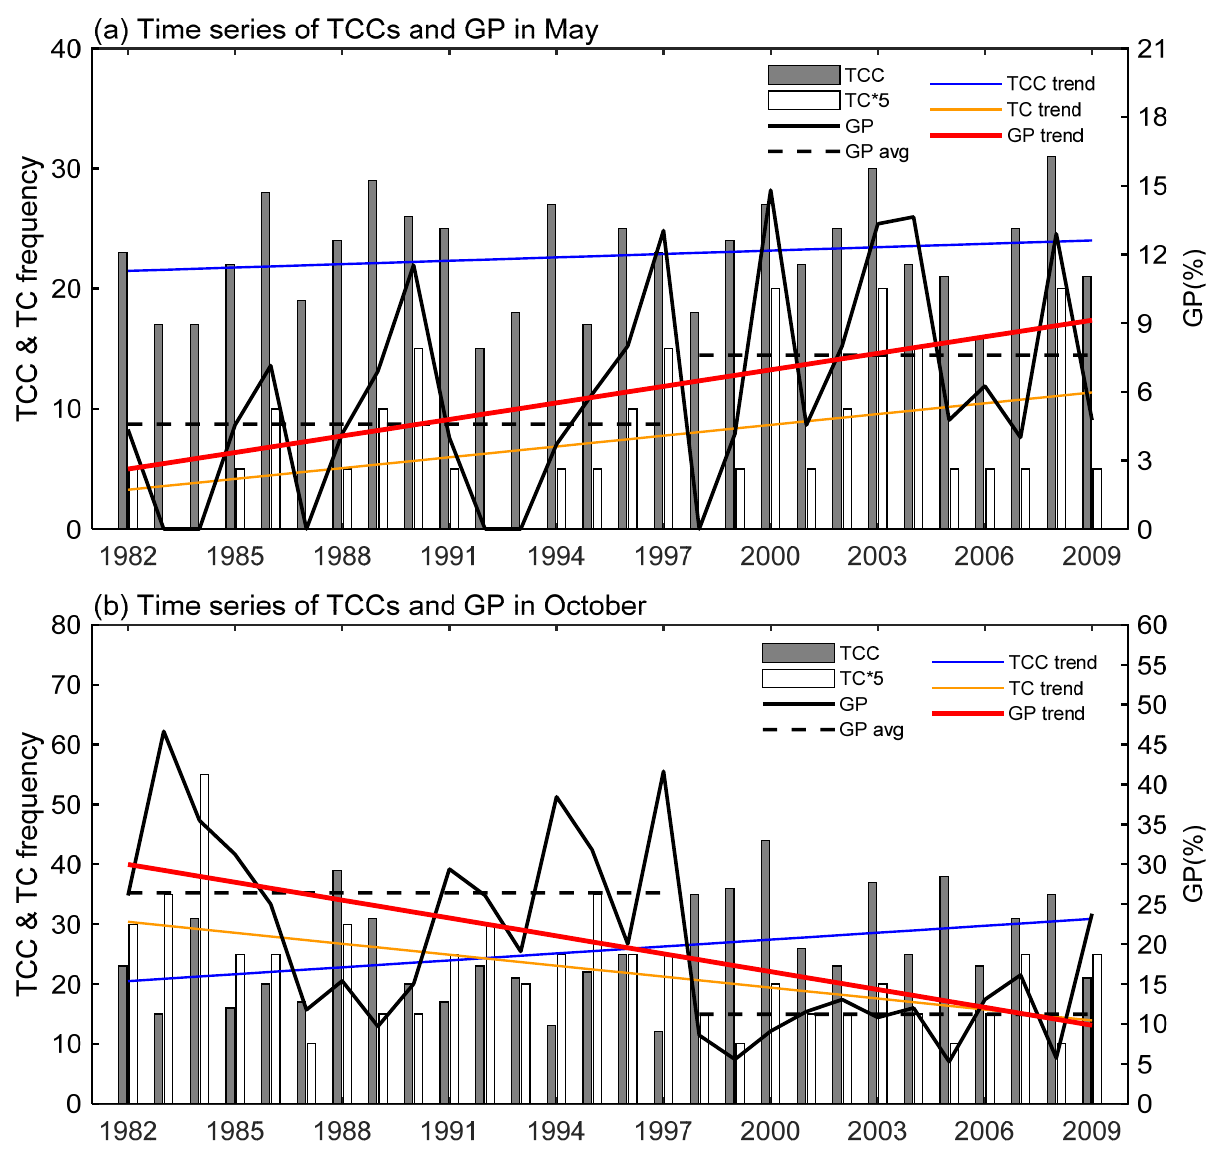
Figure 3. ( a ) Time series of the WNP TCC numbers (grey bars), TC numbers (white bars; multiplied by 5), and GP (black solid line) in May. The solid lines are for the linear trends in GP (red), TC number (yellow), and TCC number (blue) during 1982–2009. The black dotted line is for the mean GP during P1 (1982–1997) and P2 (1998–2009). ( b ) As in ( a ) but for October. TC*5 represents the TC number multiplied by 5 for the convenience of display in this figure.